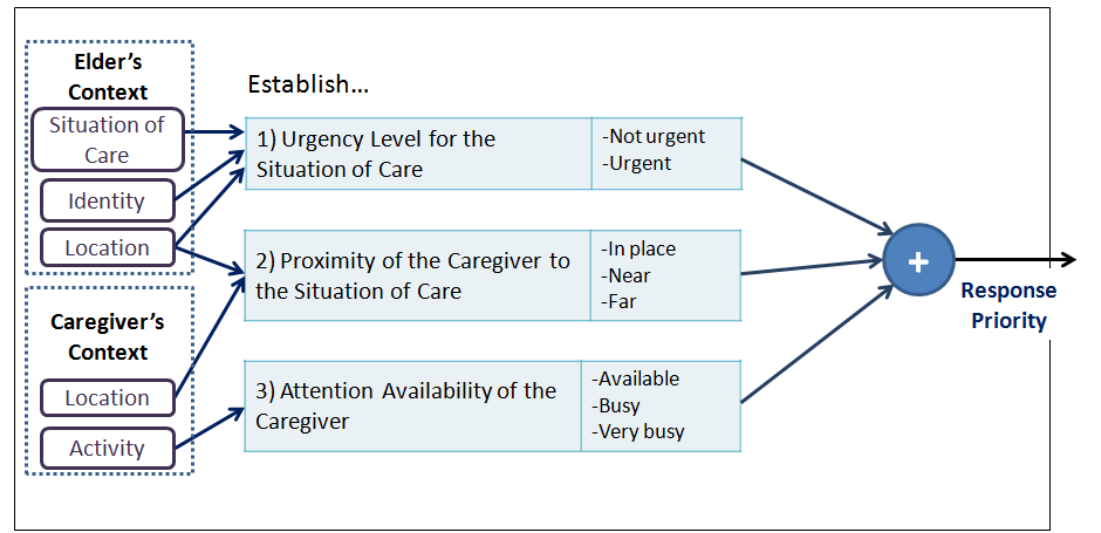
Figure 3. Model for the Configuration of the Caregiver’s Response